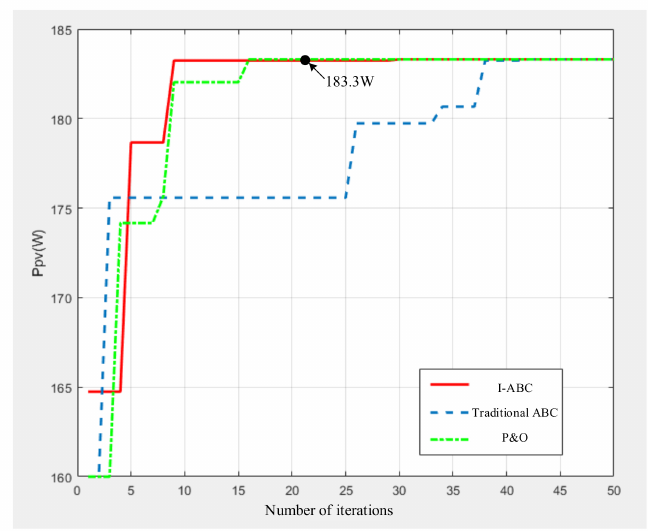
Figure 7. Comparison of simulation results for the MPPT in Case 1.